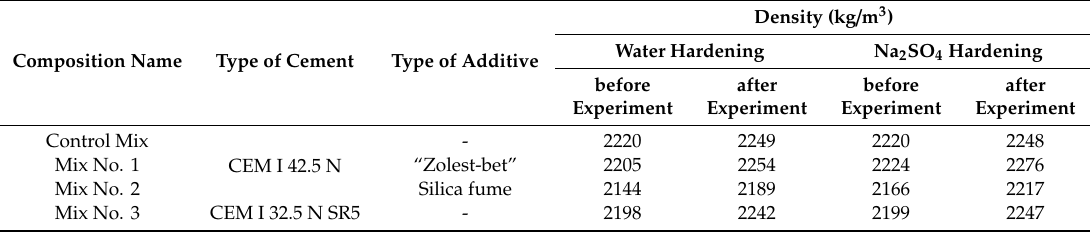
Table 6. Density test